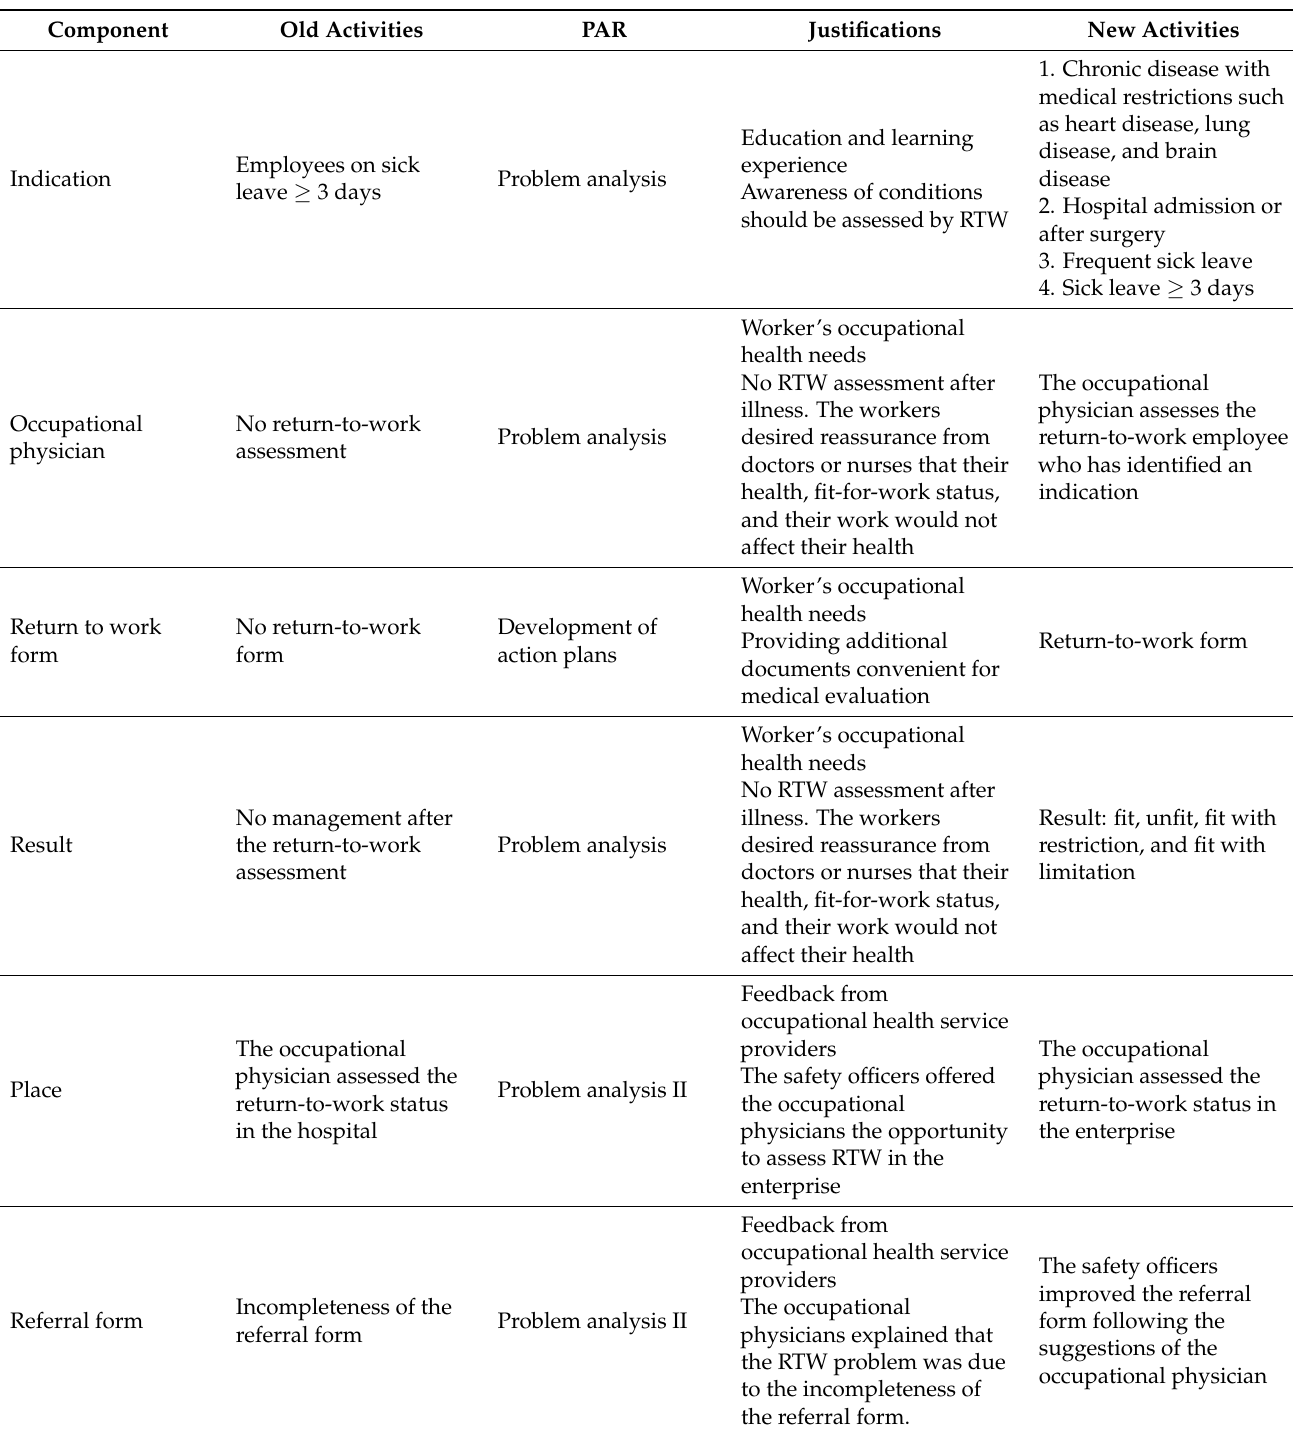
Table 12. Return-to-work model